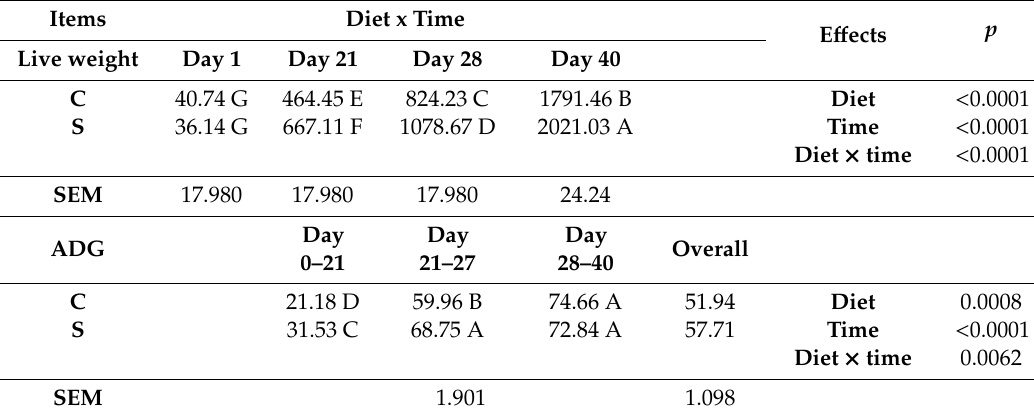
Table 1. E ff ect of Saccharomyces cerevisiae boulardii CNCM I-1079 supplemented diets on the growth performance of chickens (g).